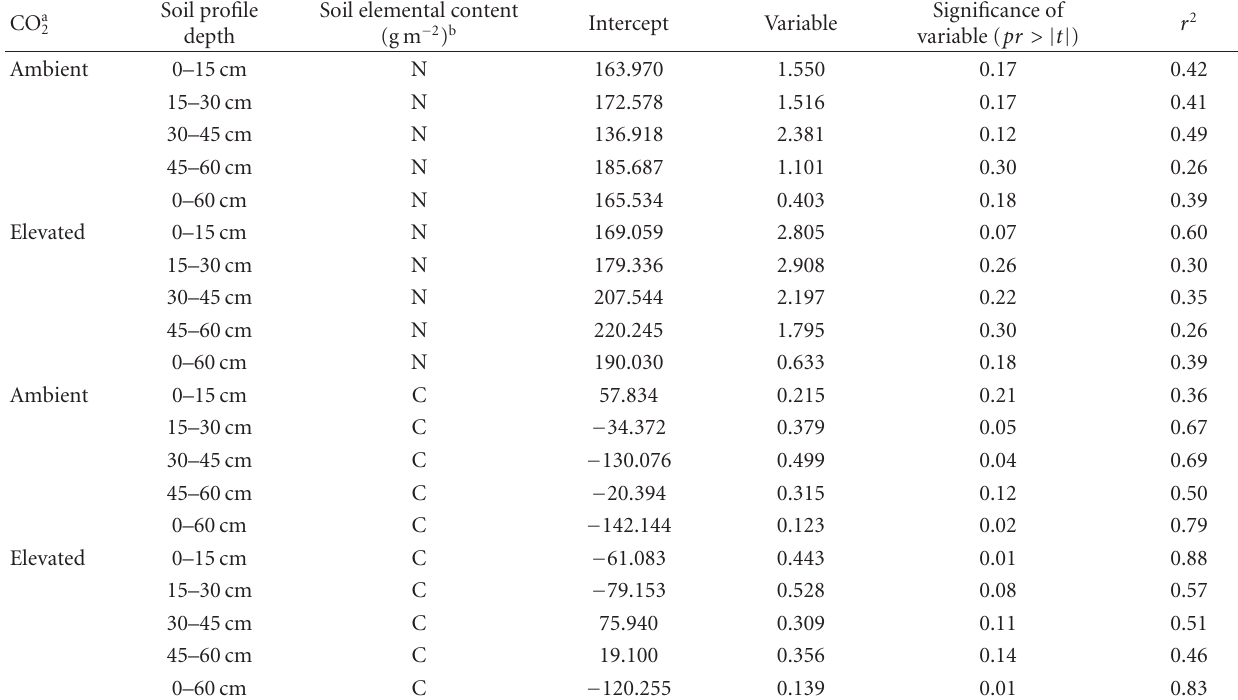
Table 1: Regression parameters and statistics for relationships of total soil CO 2 e ffl ux (gCm − 2 ) over the 90-day measurement period with soil N and C content.